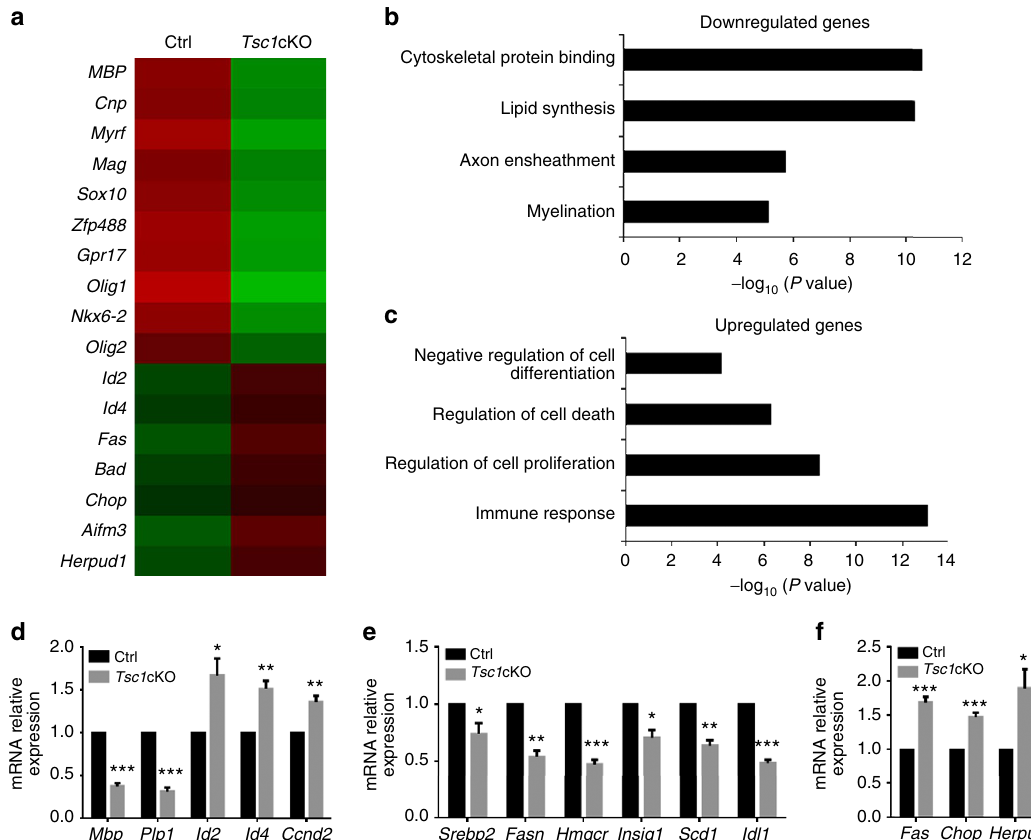
Figure 5 | Transcriptome profiling reveals enrichment of the cell survival and apoptotic pathway genes in Tsc1 cKO mutants. ( a ) Heatmap depicts gene expression of representative myelination-associated and apoptosis-related genes in control and Tsc1 cKO optic nerves at P12. ( b , c ) Gene ontology analyses of pathway enrichment among ( b ) downregulated and ( c ) upregulated genes in Tsc1 cKO as compared with control. ( d – f ) qRT–PCR analysis of representative ( d ) myelination-related genes and differentiation inhibitors, ( e ) lipid synthesis genes, and ( f ) apoptosis and stress response genes from optic nerves of control and Tsc1 cKO mice at P12. Data represent the mean ± s.e.m. from three animals. * P o 0.05; ** P o 0.01; *** P o 0.001; Student’s t